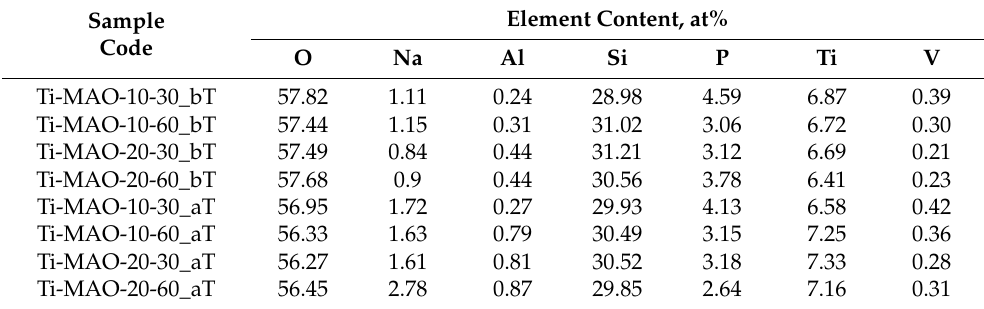
Table 4. Elemental composition of the MAO coatings surface layer before (bT) and after (aT) TCT.